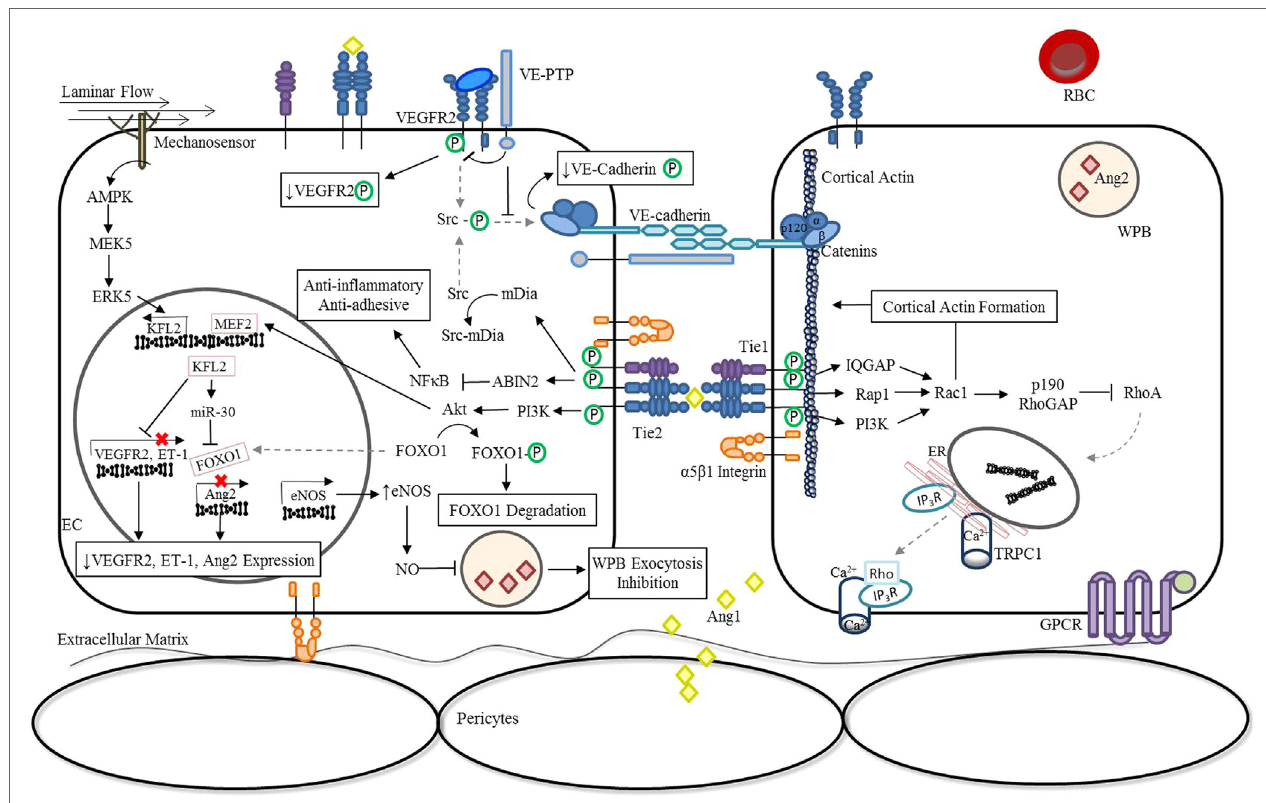
FigURe 1 | Ang/Tie pathway regulation of vascular stability. In the absence of inflammation or infection (stable vasculature), Ang1 is secreted by mesenchymal cells (22, 23) and low levels of autocrine Ang2 are constitutively secreted (24). Binding of Angs to Tie2 promotes the interaction of Tie1 and Tie2 in a β 1 integrin- dependent manner and regulates Ang-induced Tie2 trafficking to cell–cell junctions (14, 15). Under these conditions, endothelial Tie1 enhances the activity of Ang1 and is essential for Ang2 agonistic activity (14, 15). Oligomerized Ang1 also induces the translocation of Tie2 to cell–cell contacts and induces an Ang1-bridged Tie2 trans -association (17). The resulting phosphorylation of Tie2 leads to the activation a number of downstream signaling pathways that are involved in vessel stability and endothelial barrier function. Activation of the downstream serine kinase, AKT, leads to the phosphorylation and nuclear exclusion of FOXO1, and repression of its target genes which include Ang2 (18–20). Ang1 inhibition of NF- κ B reporter gene activity via activation of ABIN2 dampens the expression of adhesion molecules and pro-inflammatory cytokines (25, 26), preventing further activation of the endothelium through localized inflammatory mediators. In parallel, Ang/Tie2 signaling stimulates the transcriptional activity of MEF2 through the PI3K/AKT pathway to induce the expression of a second transcription factor KFL2 to ultimately counteract VEGF-mediated vascular permeability ( ↑ eNOS expression; ↓ VEGFR2 and ET-1 expression) (27). The increase in NO generated by eNOS combined with the negative regulation of Ang2 expression during quiescence significantly reduces luminal concentrations of Ang2 (28). In addition, KFL2 induces miR-30 expression, further blocking the transcription of Ang2 (29). The phosphorylation of Src, which generally culminates in the phosphodependent internalization of VE-cadherin, is also inhibited by Ang1/Tie2. Signaling through Ang1 leads to the activation of mDia, resulting in the sequestration of Src, and prevention of subsequent phosphorylation by VEGFR2 (30). At cell–cell junctions, Ang1/Tie2 also blocks VEGF signaling by promoting the interaction of VEGFR2 with VE-PTP (31). Lastly, activation of Tie2 can lead to the activation of the GTPase, Rac1, via IQGAP (32), Rap1 (33), or PI3K/Akt (34)-dependent pathways to stabilize the cortical actin cytoskeleton and maintain adherens and tight junctions between cells (35). In the presence of LPS, activation of the RhoA-specific GTPase activating protein, p190RhoGAP, by Rac1, is essential for shifting the balance away from RhoA rearrangement of the actin cytoskeleton and preventing vascular permeability (32, 35). Abbreviations: ABIN2, A20-binding inhibitor of nuclear factor- κ B-2; Ang1, angiopoietin-1; Ang2, angiopoietin-2; EC, endothelial cell; eNOS, endothelial nitric oxide synthase; ER, endoplasmic reticulum; ET-1, endothelin-1; FOXO1, forkhead box protein O1; GPCR , G-protein-coupled receptor; IP 3 R, inositol triphosphate receptor; IQGAP, IQ motif containing GTPase activating protein; KLF2, Krüppel-like factor-2; LPS, lipopolysaccharide; mDia, mammalian diaphanous; MEF2, myocyte enhancer factor-2; miR-30, microRNA-30-5p; NF- κ B, nuclear factor- κ B; NO, nitric oxide; PI3K, phosphoinositide triphosphate kinase; Rac1, RAS-related C3 botulinum toxin substrate 1; Rap1, Ras-related protein 1; RBC, red blood cell; RhoA, Ras homolog gene family, member A; Src, proto-oncogene tyrosine-protein kinase; TRPC1, transient receptor potential channel-1; VE-cadherin, vascular endothelial-cadherin; VEGF, vascular endothelial growth factor; VEGFR2, vascular endothelial growth factor receptor 2; VE-PTP, vascular endothelial protein tyrosine phosphatase; WPB, Weibel-Palade Body; P,